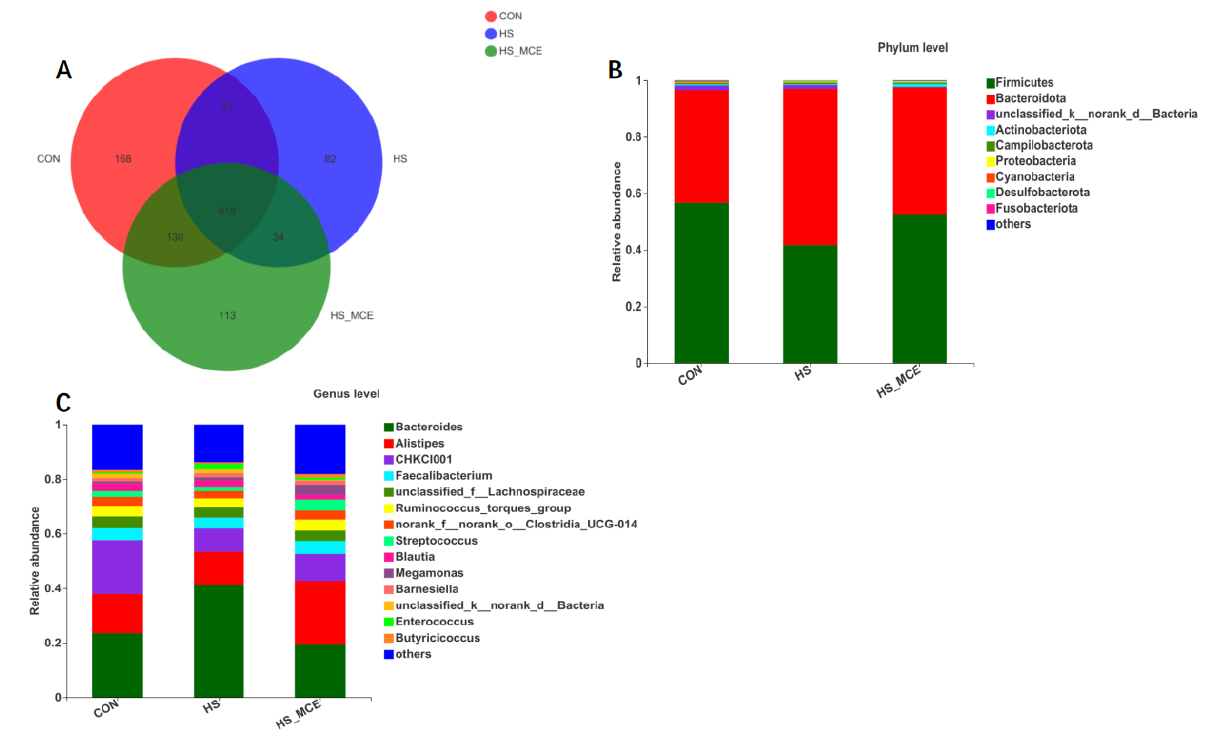
Figure 1. The Venn diagram and bacterial community composition of yellow-feathered broilers. ( A ) The Venn diagram of OTUs. ( B ) Microbial composition in the cecum at the phylum level. ( C ) Microbial composition in the cecum at the genus level. Abbreviations: CON, control group; HS, heat stress group; HS-MCE, Heat Stress plus MCE group.